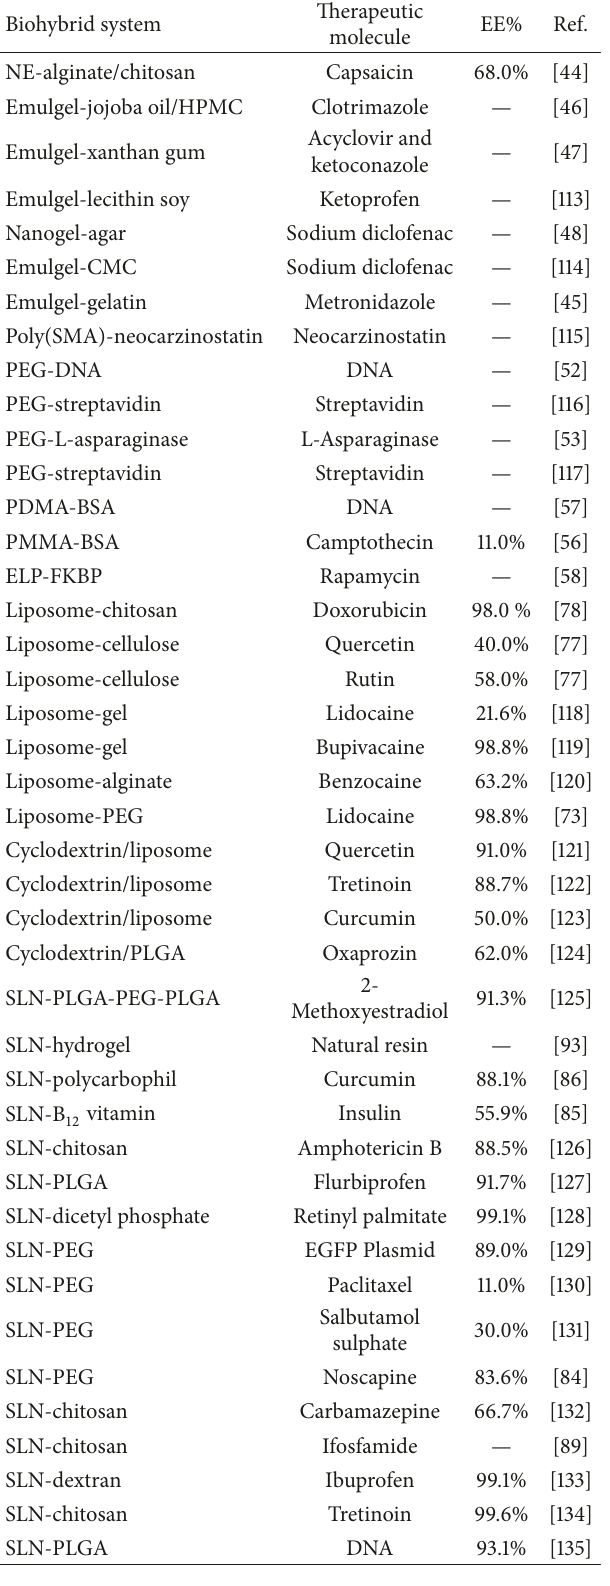
Table 2: Main published works regarding biohybrid systems for sustained drug delivery, listed in terms of kind, activity, and encapsulation efficiency (EE%).